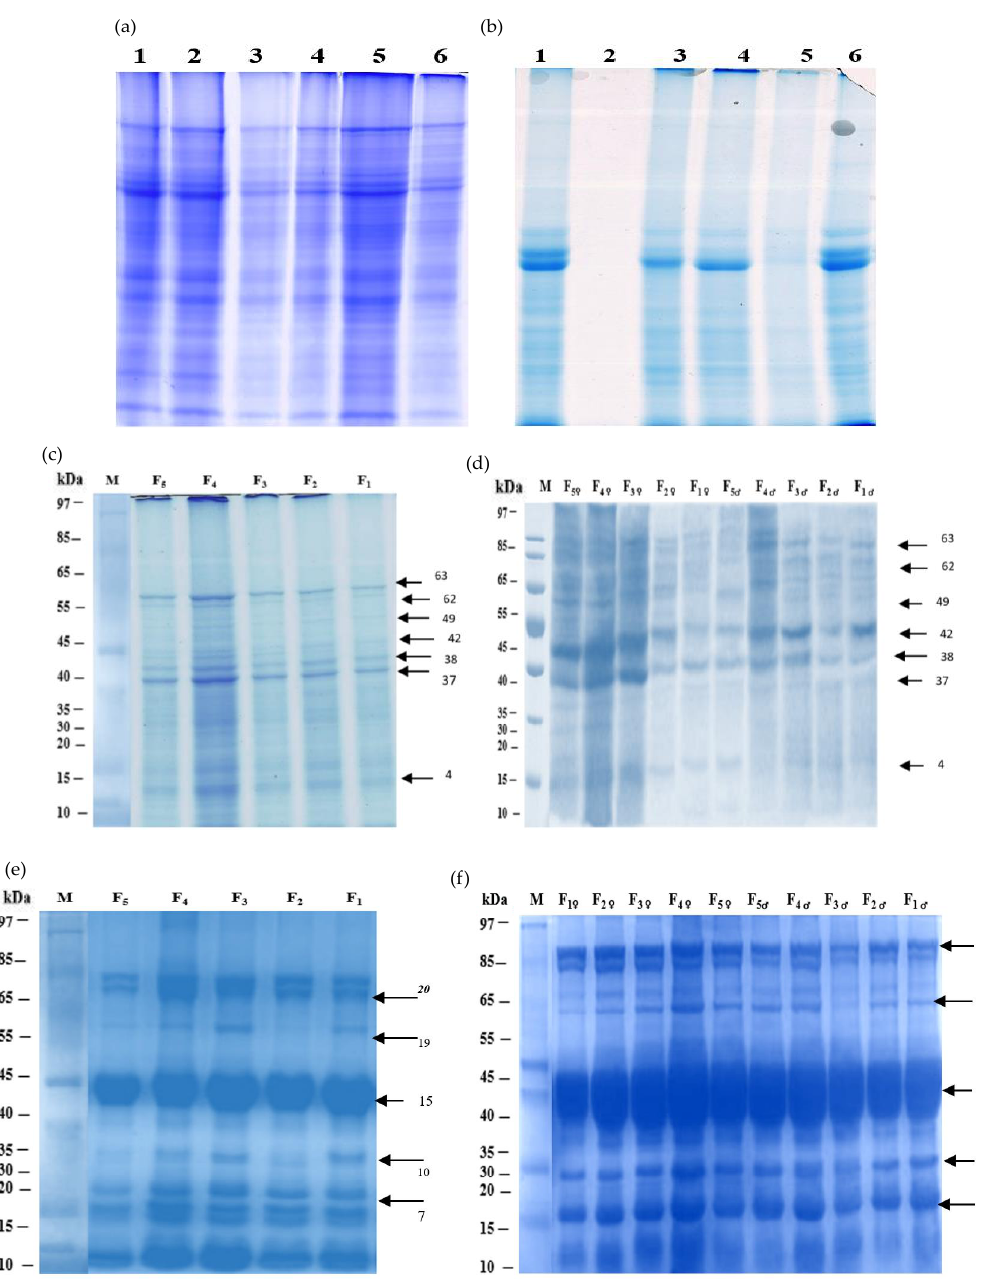
Figure 3. ( a ) Gel showing different protein extraction methods in bottle gourd leaves. Lane 1, SDS;